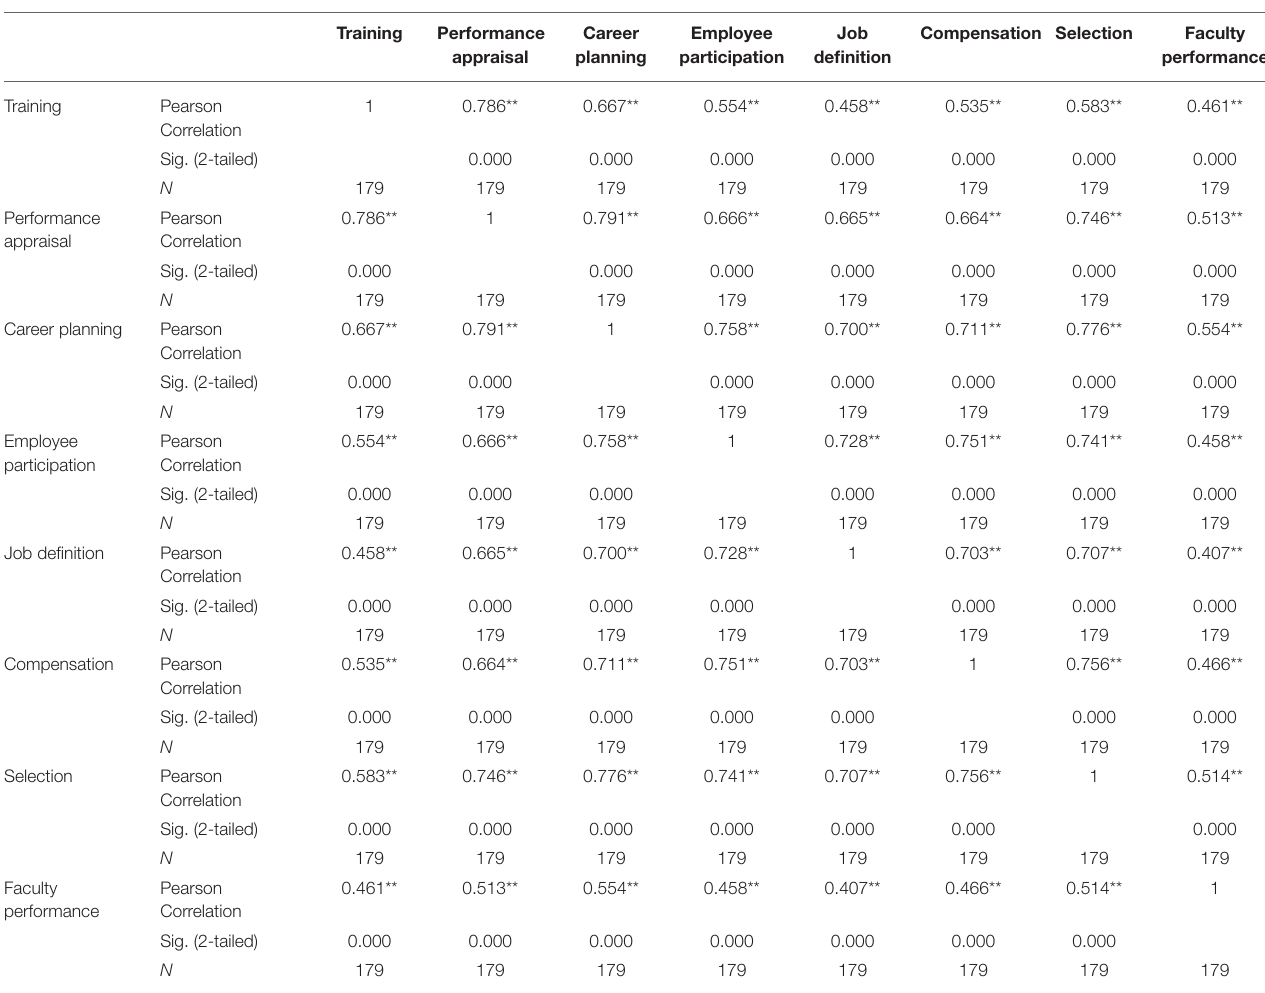
TABLE 5 | Correlation